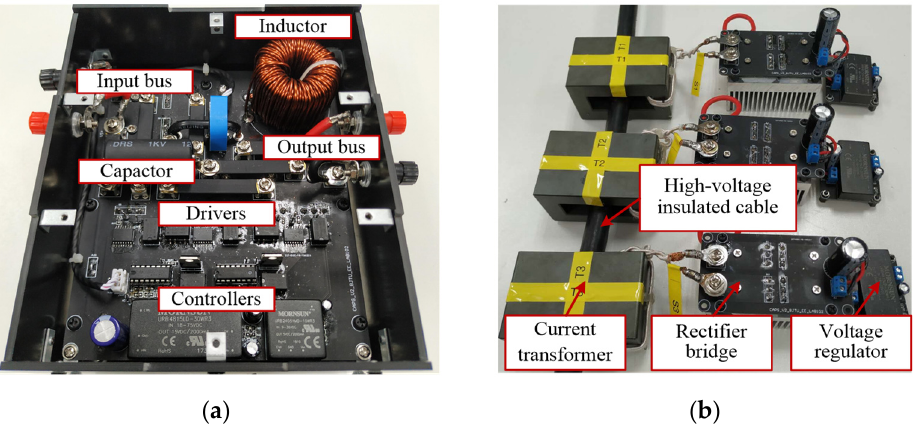
Figure 10. Experimental prototype. ( a ) Current source converter and inverter circuit. ( b ) Current transformers and rectifier bridges.